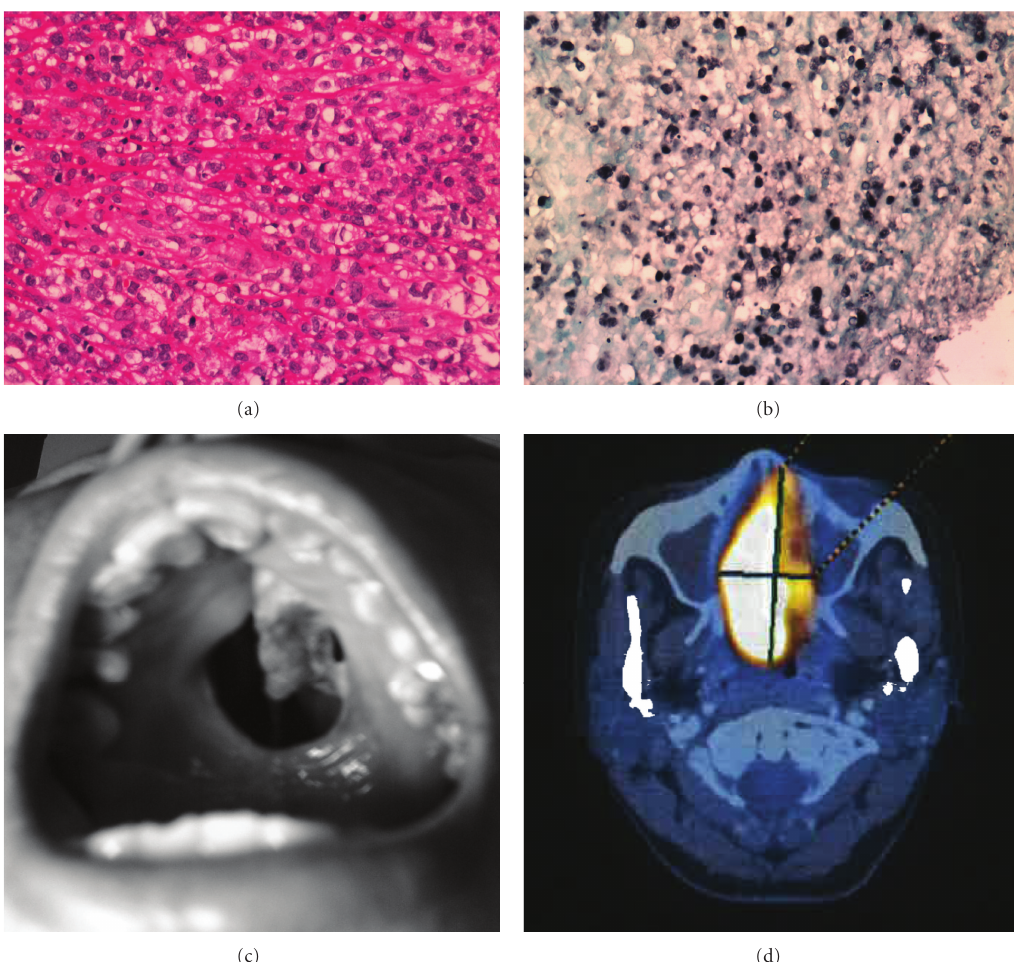
Figure 1: (a) Histology of NK/T-cell lymphoma showing presence of atypical lymphoid cells, which are medium to large in size with irregular and hyperchromatic nuclei. (b) In situ hybridization for Epstein Barr virus-encoded early RNAs (EBER) positivity in NK/T-cell lymphoma. (c) NK/T-cell lymphoma of the nasal type presenting with perforation of hard palate. (d) PET/CT scan of a patient with NK/T-cell lymphoma showing a FDG-avid mass in the right nasal